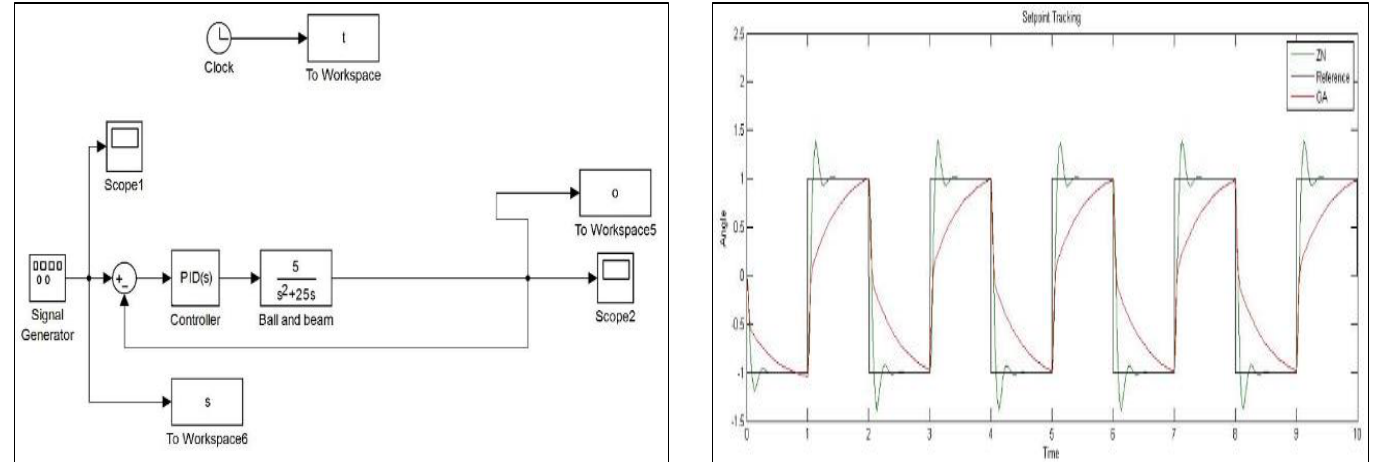
Figure 13: Set-point